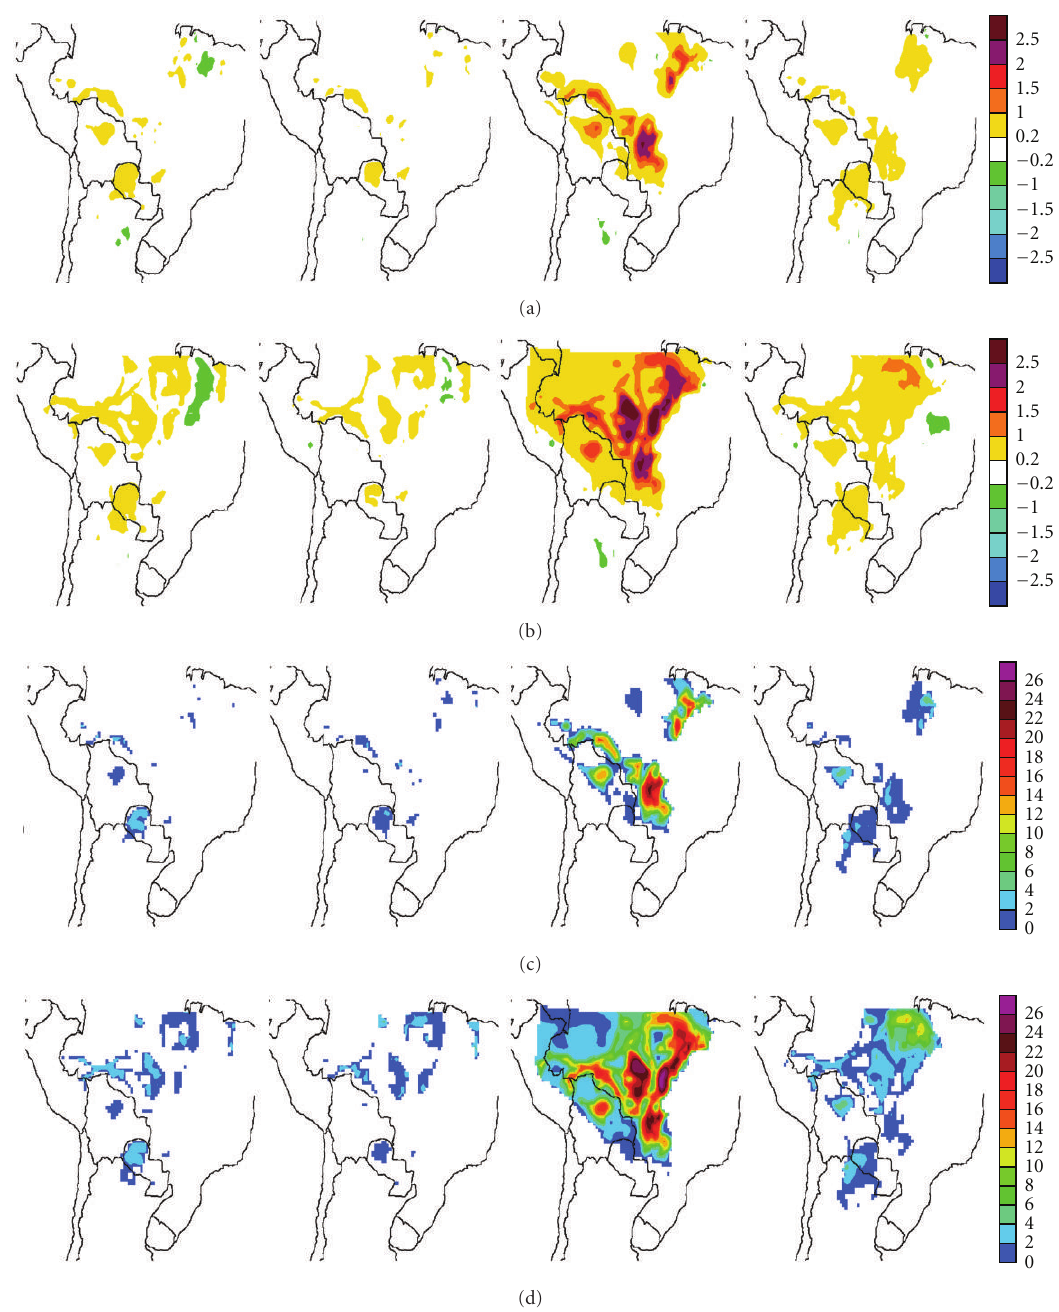
Figure 10: Seasonal temperature changes, in ◦ C, resulting from the two deforestation/land-use scenarios in ECHAM-4 Baseline driven PRECIS runs, for (a) MAP1 and (c) MAP2. The corresponding significances at least at the 95% level are shown in (b) and (d), respectively. Starting from the left the columns correspond to summer (DJF), autumn (MAM), winter (JJA), and spring